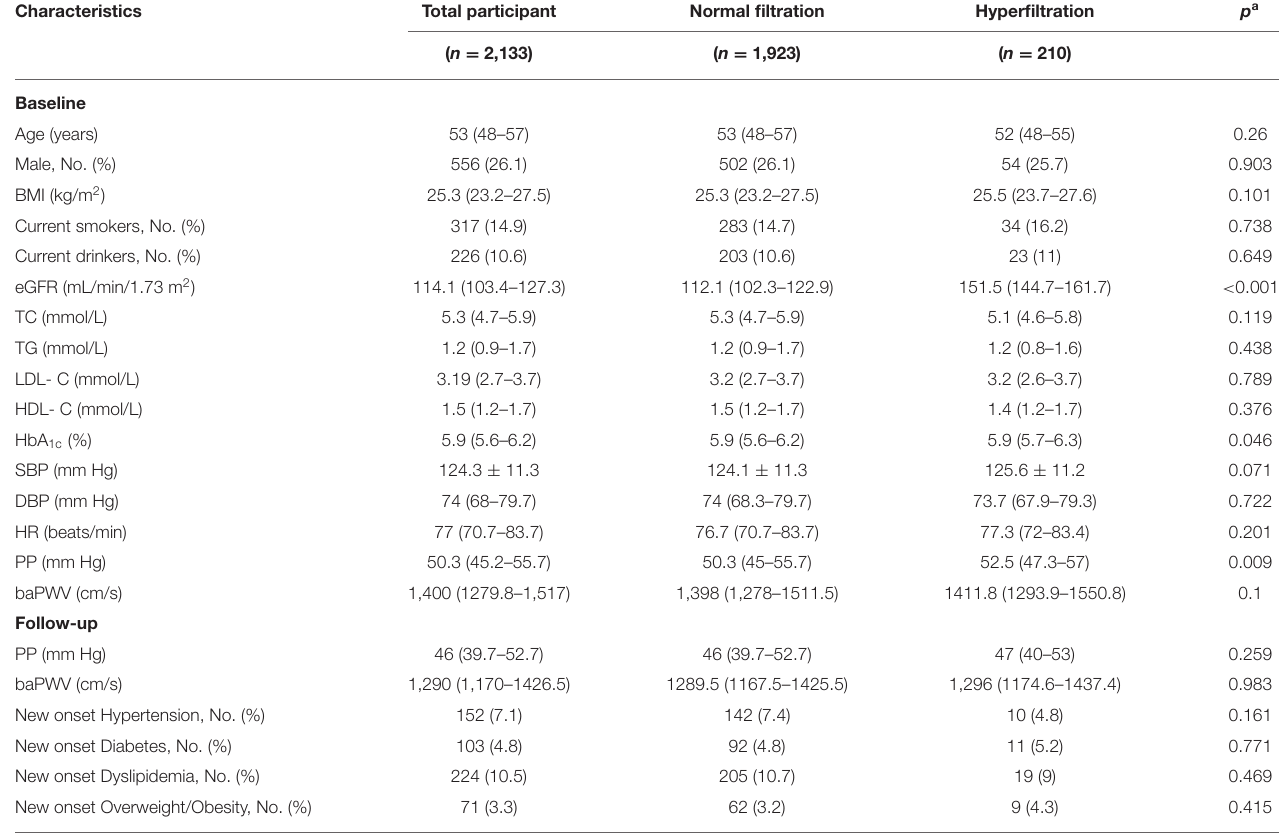
TABLE 1 | Characteristics of individuals with normal glomerular filtration or hyperfiltration.